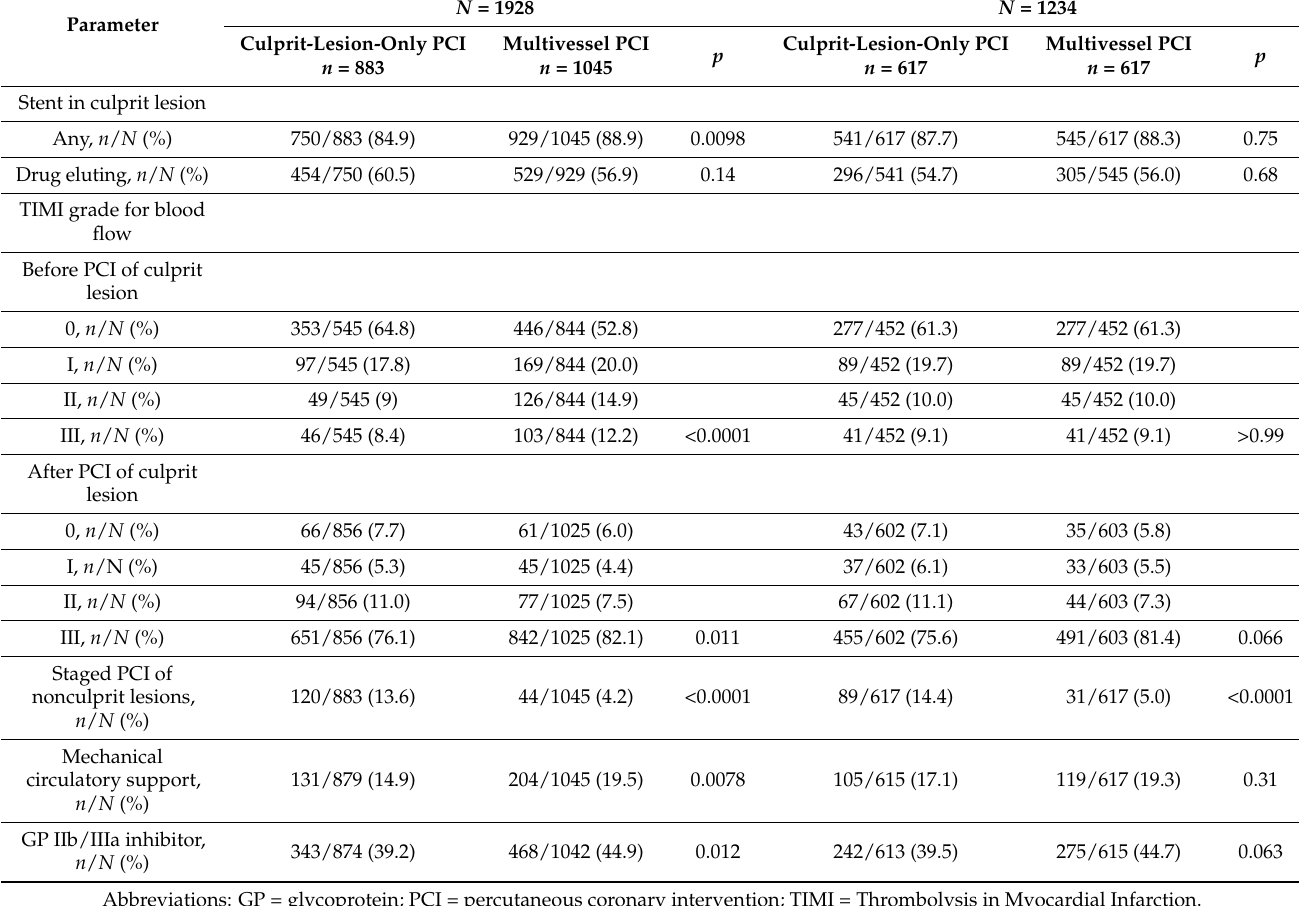
Table 2. Procedural characteristics of study groups of the PL-ACS registry and the CULPRIT-SHOCK trial.